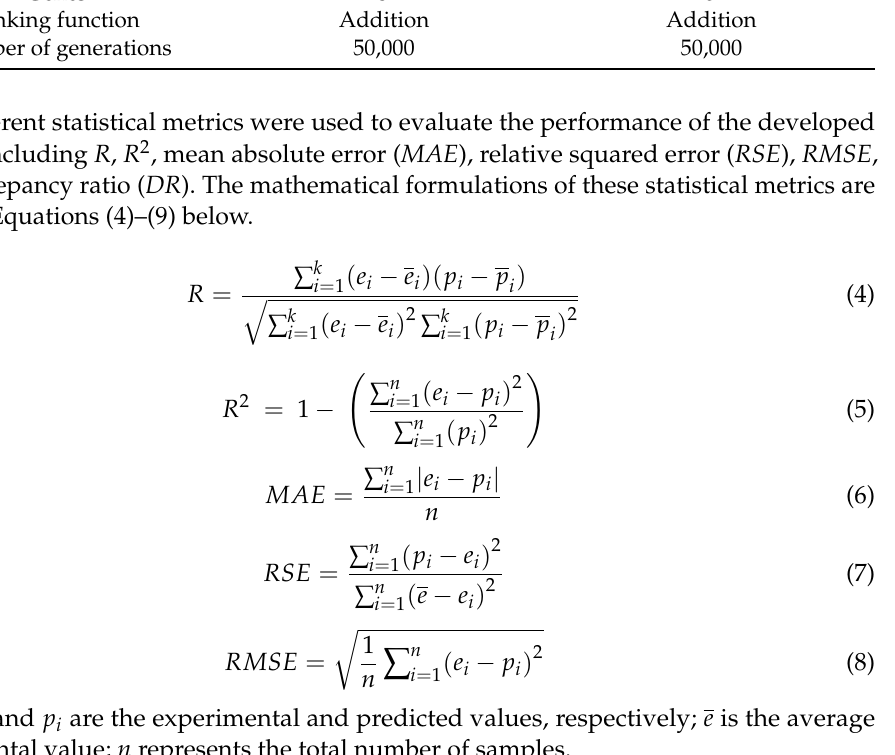
Table 2. Parameters of the developed GEP models. Parameters GEP Model for CS GEP Model for STS Head size Chromosome Linking function Addition Addition Number of